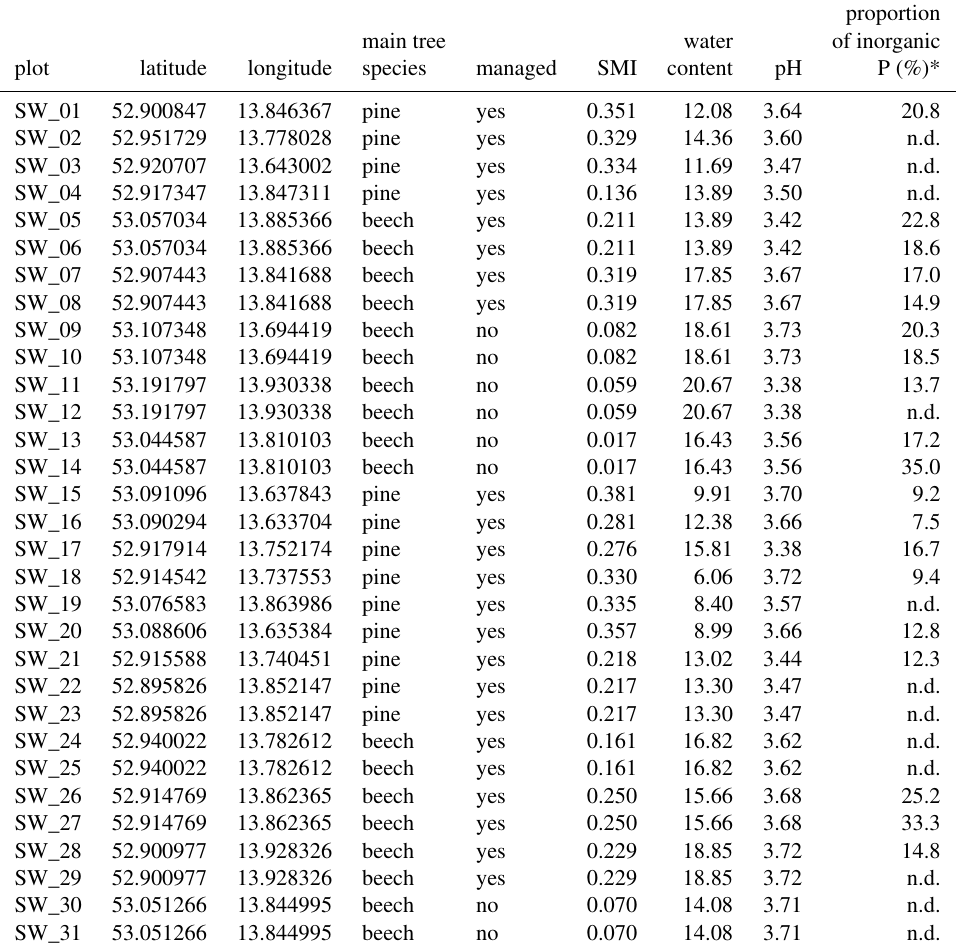
Table 1. General information on study sites: sample location, main tree species, management status, silvicultural management index (SMI), water content and pH from bulk soil analyses, and proportion of inorganic P as % of total P. n.d.: not determined; * Taken from Baumann et al.